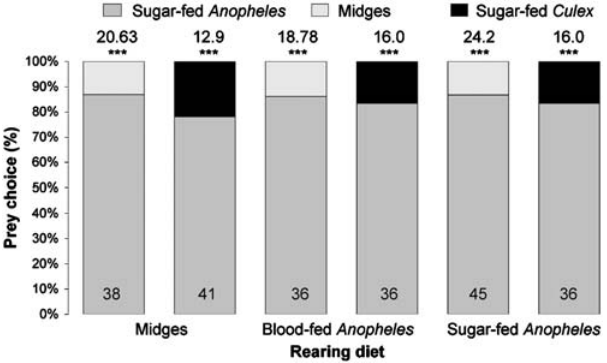
Figure 5. Simultaneous-presentation mount tests of sated Evarcha culicivora females (body length 6.5 mm) from cultures with non- standard feeding regimes (midges only, blood-fed Anophelesonly and sugar-fedAnophelesonly). N inside each bar. Tests of goodness of fit: chi-square statistic above bar; null hypothesis, 50/50; *** P , 0.001.